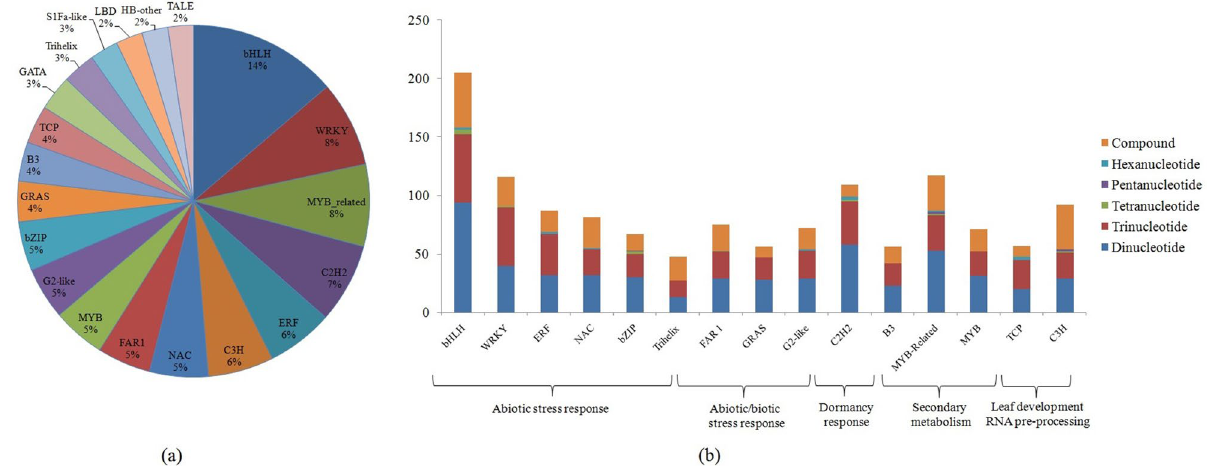
Figure 2. Details of transcription factors families harbouring SSRs in tea: ( a ) Top 20 SSR containing transcription factor families; ( b ) Distribution and frequency of various repeat types and functional relevance of major transcription factor